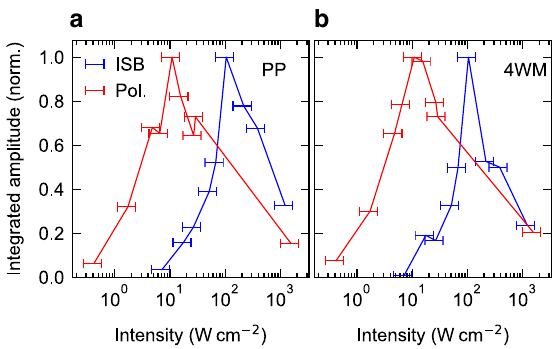
Fig. 4 Dynamics of the nonlinear response as a function of pump intensity. a Integrated PP signal (red curve) as a function of peak intensity of the incident THz pulses. The blue line indicates the experimental values for a bare ISB transition. The error bars state the systematic uncertainty of the determination of the peak intensity. b Corresponding curves for the 4WM